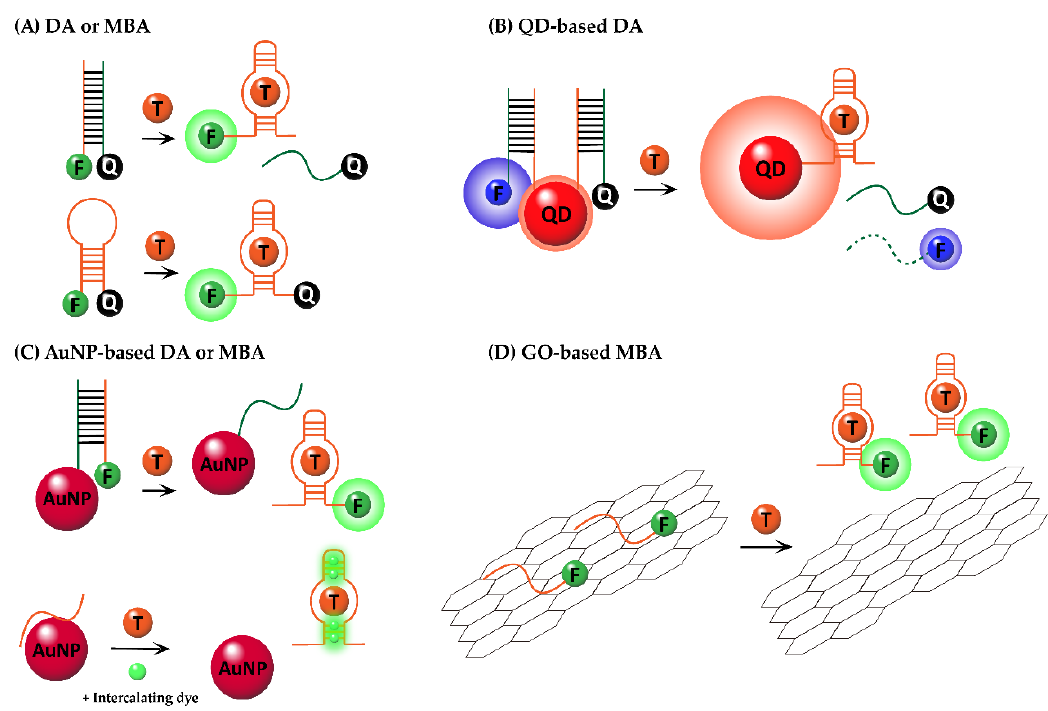
Figure 1. Schematic illustration of fluorogenic aptasensors for the detection of small targets (T). ( A ) DA or MBA linked to fluorophore (F) and quencher (Q). ( B ) QD-based DA labeled with Q or F. ( C ) AuNP-based DA or MBA labeled with F. ( D ) GO-based MBA labeled with F. DA, duplex aptasensors; MBA, molecular beacon-type aptasensors; QD, quantum dot; AuNP, gold nanoparticle; GO, graphene oxide.